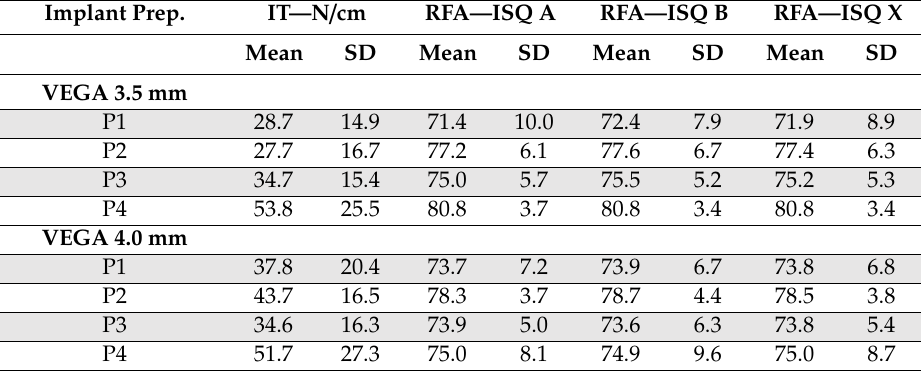
Table 2. Values of the IT and ISQ for the 4 di ff erent types of implant preparation technique for 3.5 and 4.0 mm diameter implants. Implant Prep.—implant preparation; IT—insertion torque; RFA—resonance frequency analysis; ISQ A—ISQ first measurement; ISQ B—ISQ second measurement; ISQ X—mean of ISQ A and B; SD—standard